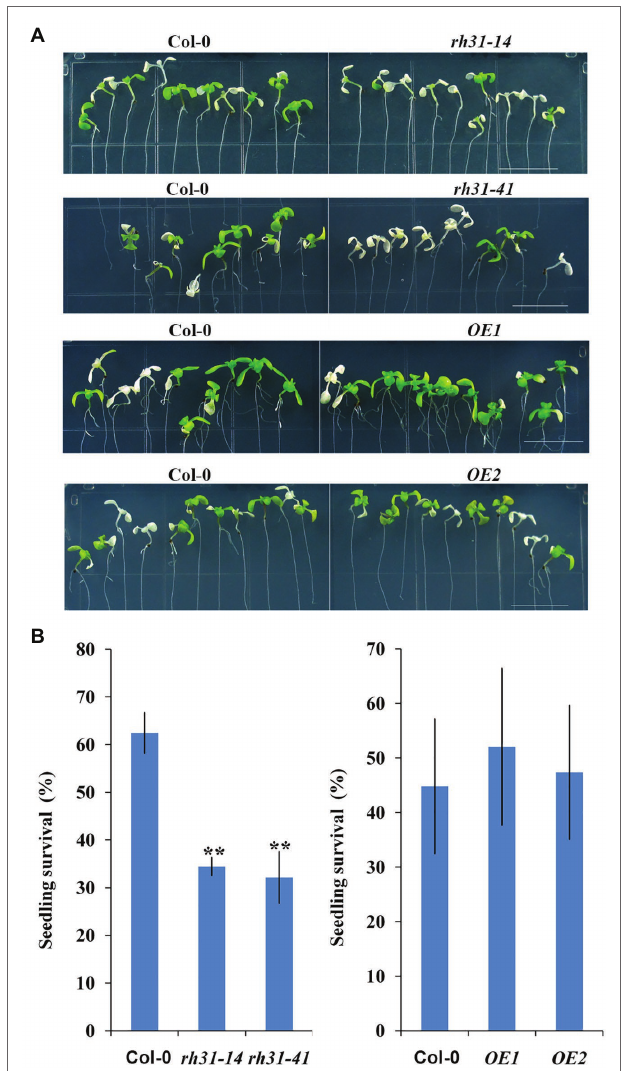
FIGURE 6 | Survival Phenotype characterization of rh31 and RH31 overexpression lines ( OE 1, OE 2). (A) Survival phenotype of Col-0, rh31-14 , rh31-41 , and 35S: RH31 seedlings under salt treatment. Plants were grown on 1/2 MS medium for 6 days and then transferred onto 1/2 MS medium supplemented with 200 mM NaCl for 5 days. Experiments were repeated three times with similar results. Scale bars = 1 cm. (B) Survival rate of seedlings shown in (A) . At least 30 seedlings were examined per replicate ( n = 3 replicates). * p < 0.05 and ** p < 0.01 (Student’s t -test) indicate significant differences between mutants or transgenic lines and Col-0 plants. Error bars indicate the standard error for the average of three independent experiments.